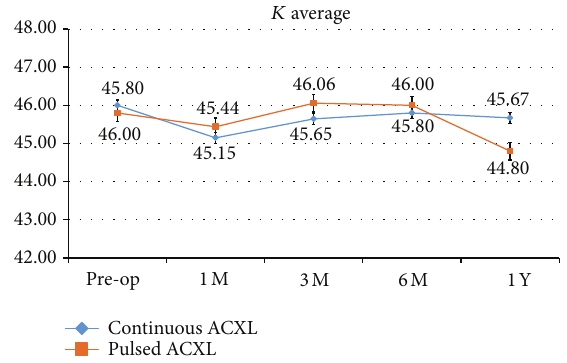
Figure 3: Topographic simulated K average ( K ave.) value after con- tinuous light (blue line) and pulsed light (orange line) accelerated crosslinking demonstrated a not statistically significant decrease by a mean value − 0.13 Diopters; the reduction of K average was found to be statistically significant by a mean value of − 1.2 Diopters after pulsed light accelerated CXL.